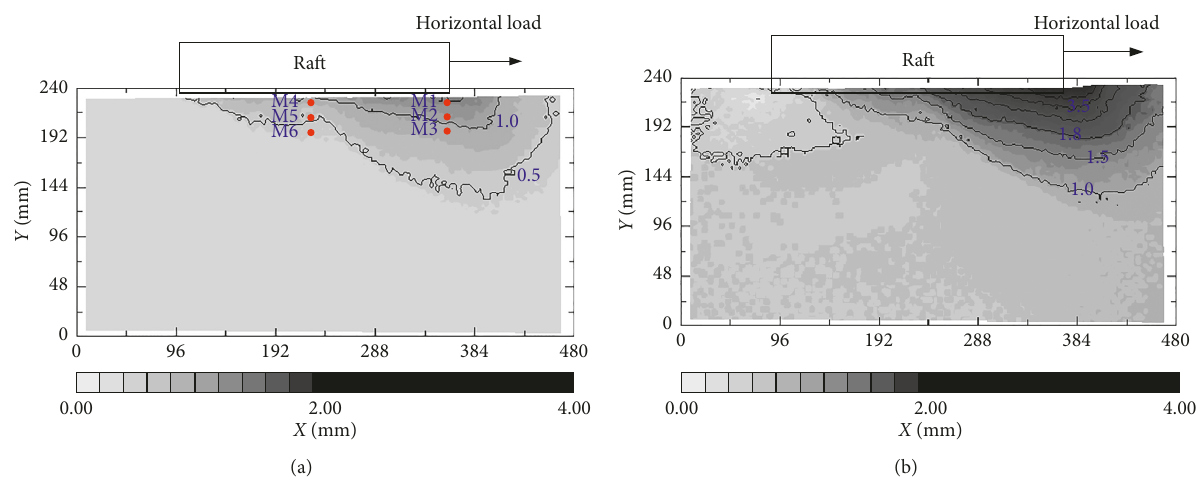
Figure 12: Soil displacement nephogram: horizontal load of (a) 100N and (b) 500N.